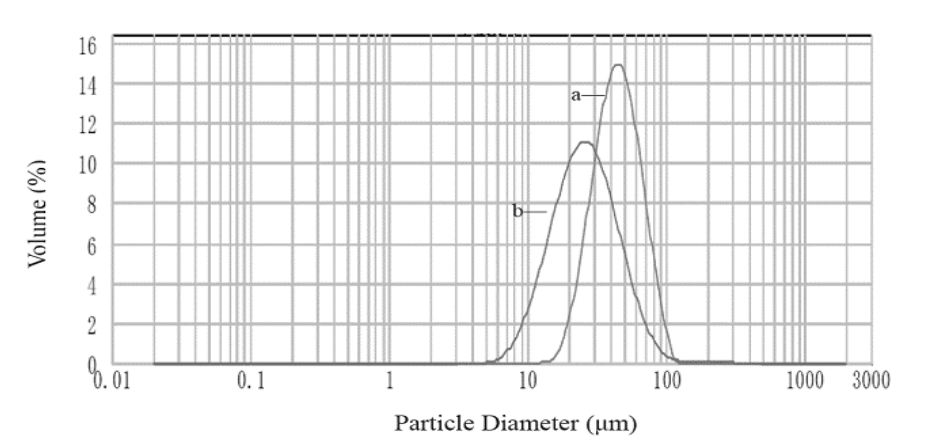
Figure 3. Particle size distribution of CaAlg beads ( a ) and CACM ( b ) particle diameters reported as volume-based in